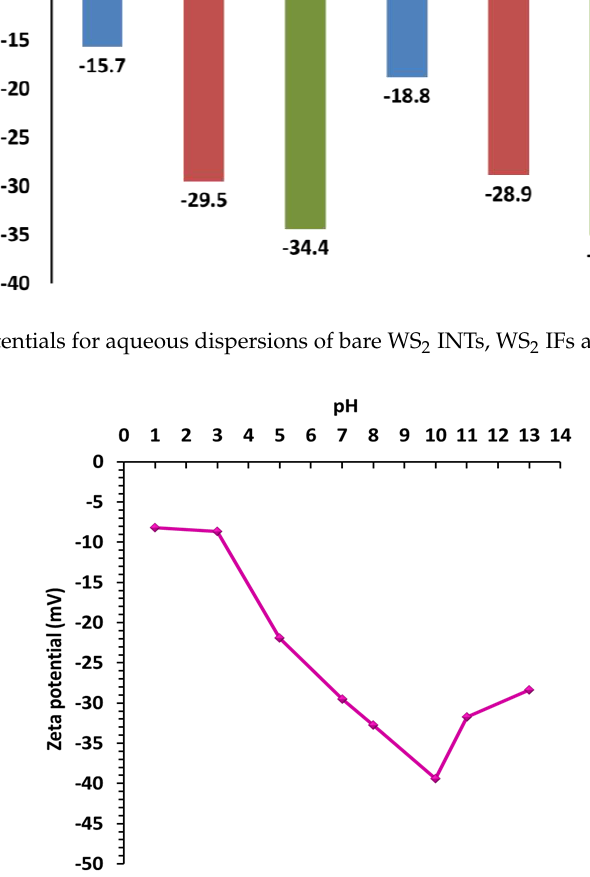
Figure 8. Zeta potential vs. pH for sample INT-SiO 2 -1P.